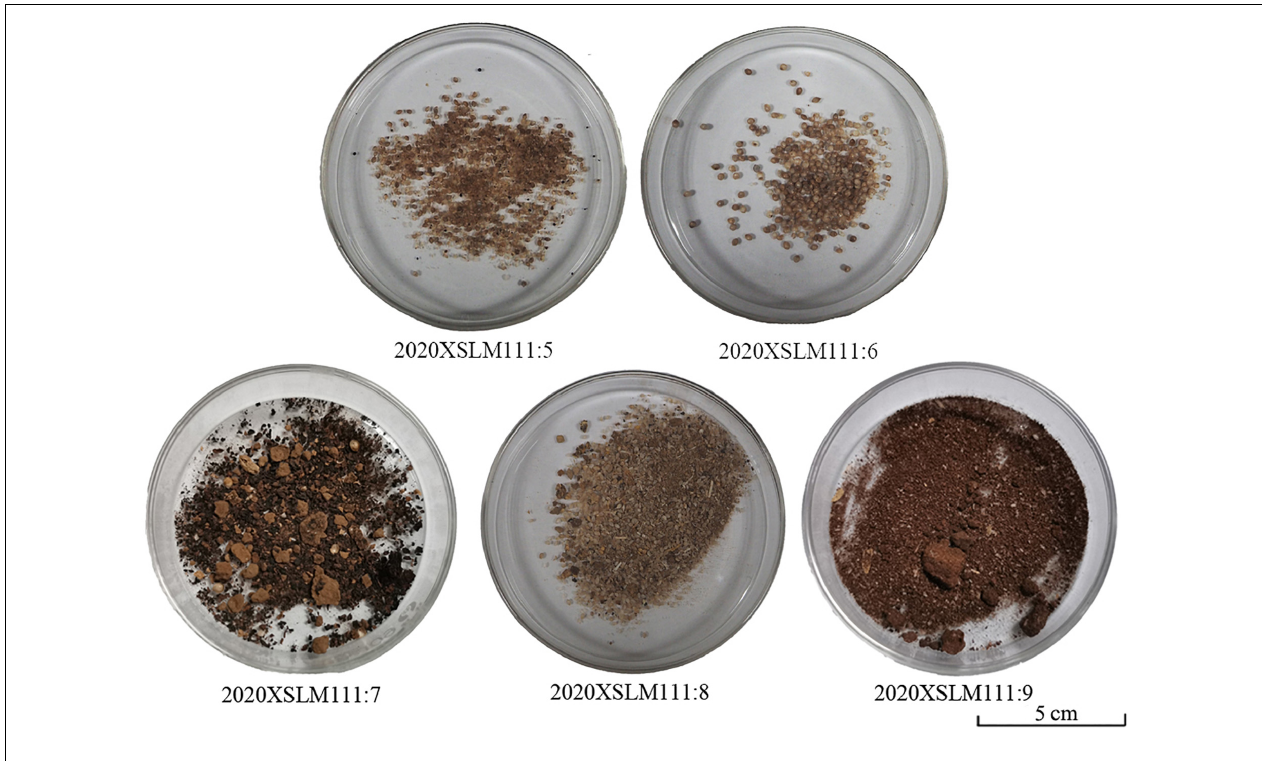
FIGURE 3 | Study samples collected from the Longzaocun cemetery M111.